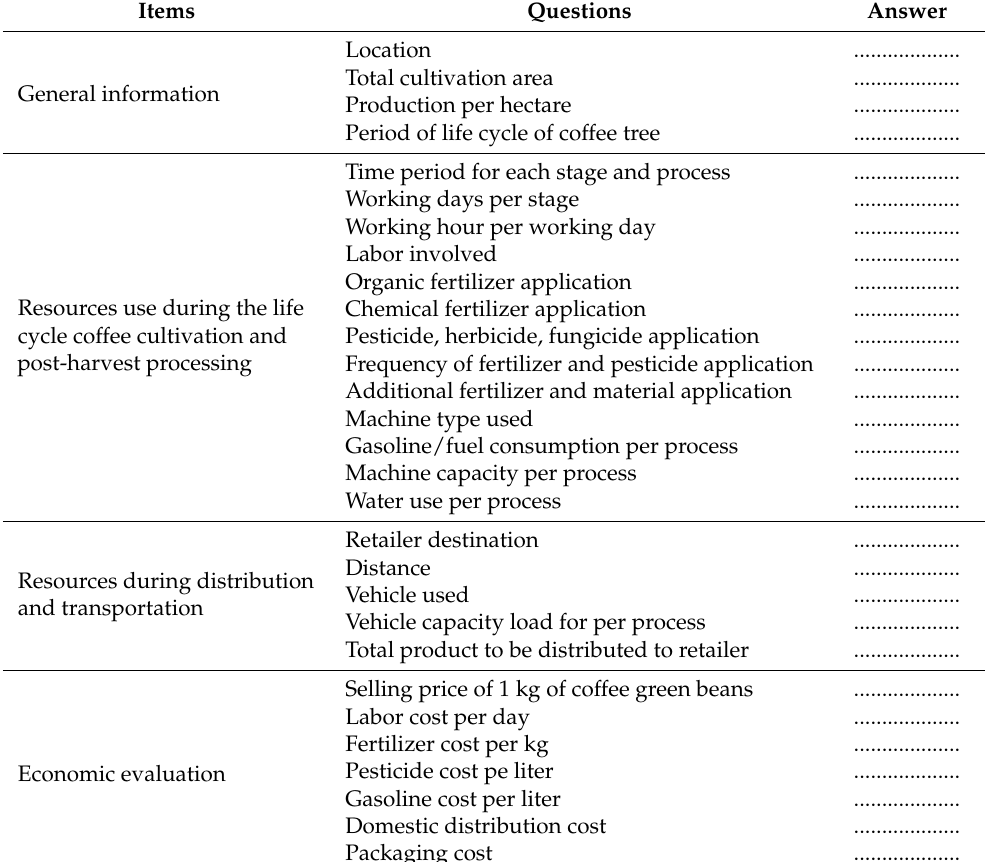
Table A1. Brief questionnaire for data